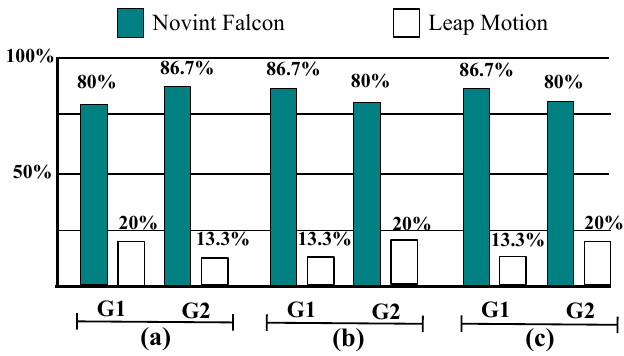
Fig. 4. Results of questions to both groups (G1 and G2): a) Which device do you consider that allows you to have a more effective result in the therapy